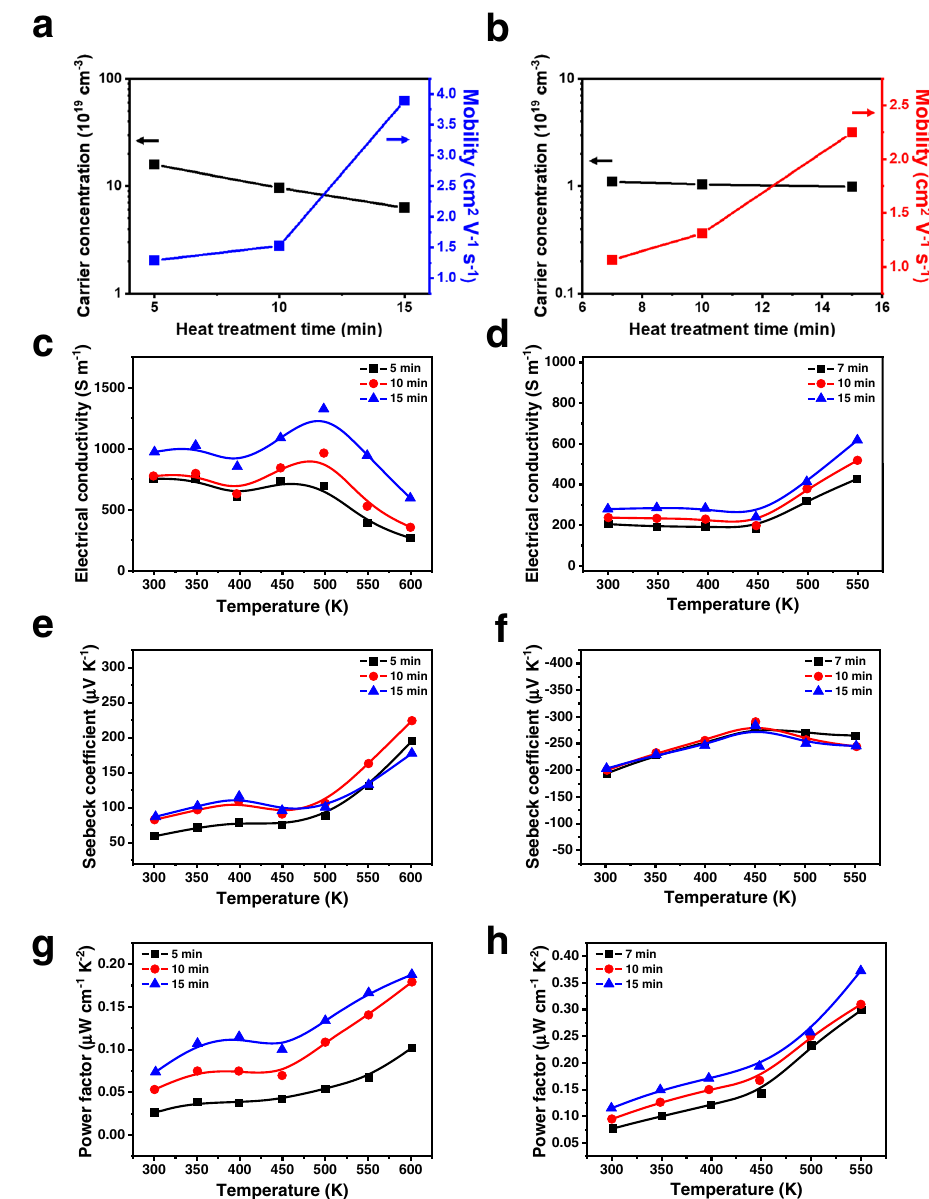
Fig. 4 | Functionality of the printed metal chalcogenide semiconductors. Charge carrier mobility and concentration of the printed a Cu 2 S and b SnSe 2 as functions of the heat treatment time as detected by Hall effect